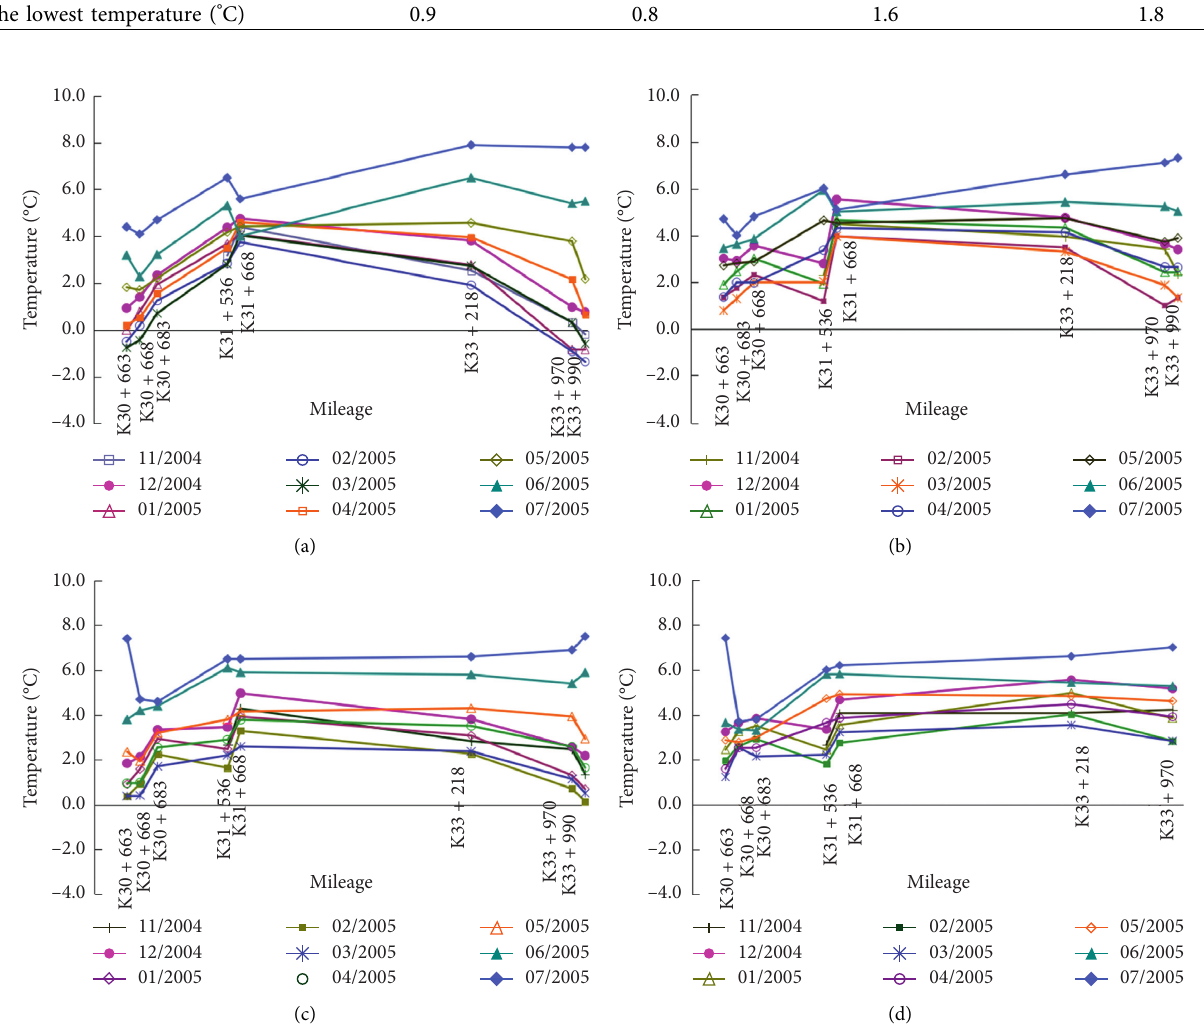
Figure 9: The ground temperature distribution at different depths along the tunnel. (a) Ground temperature at the depth of 1.5m. (b) Ground temperature at the depth of 2.5m. (c) Ground temperature at the depth of 2m. (d) Ground temperature at the depth of